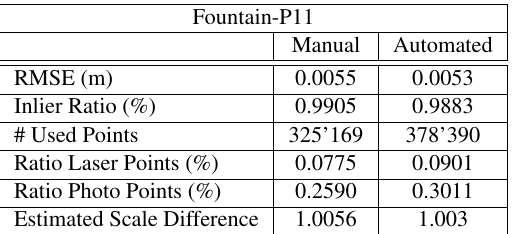
Table 5: Fountain-P11 results